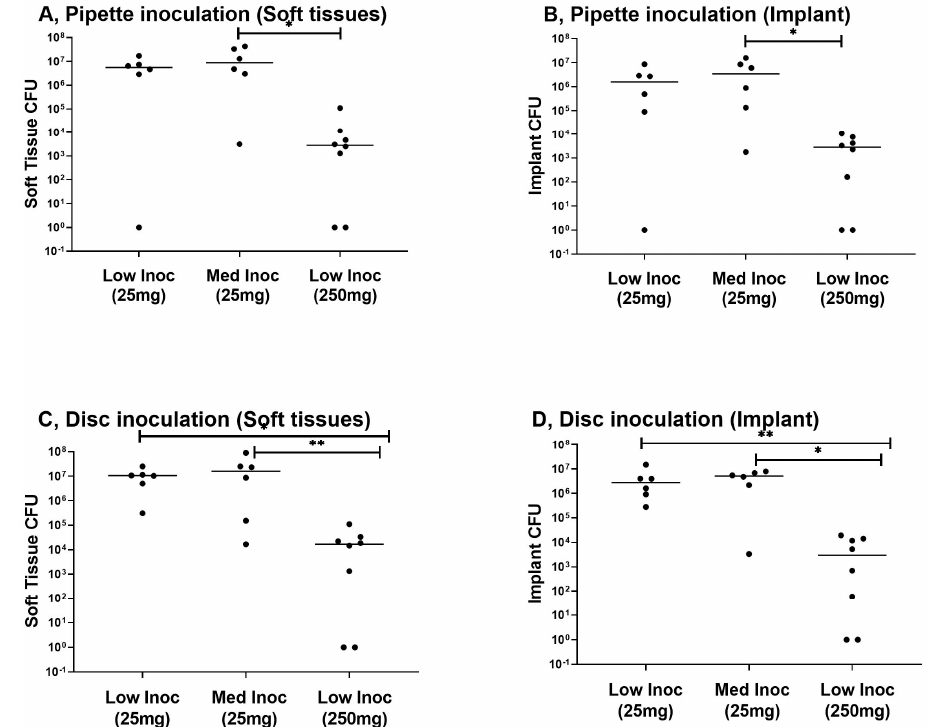
Figure 3. Results of systemic antibiotic prophylaxis phase. Results are grouped according to inoculation method and sample type for the low inoculum, treated with 25 mg (n = 6) or 250 mg (n = 8) of cefazolin and the medium inoculum, treated with 25 mg of cefazolin (n = 6). ( A ) Pipette inoculation, soft tissue sample, * statistical significance between the low inoculum treated with 250 mg of cefazolin and the medium inoculum treated with 25 mg of cefazolin ( p = 0.01); ( B ) Pipette inoculation, implant sample, * statistical significance between the low inoculum treated with 250 mg of cefazolin and the medium inoculum treated with 25 mg of cefazolin ( p = 0.03); ( C ) Disc inoculation, soft tissue sample, * statistical significance between the low inoculum treated with 250 mg of cefazolin and the low inoculum treated with 25 mg of cefazolin ( p = 0.01), ** statistical significance between the low inoculum treated with 250 mg of cefazolin and the medium inoculum treated with 25 mg of cefazolin ( p = 0.02); ( D ) Disc inoculation, implant sample, * statistical significance between the low inoculum treated with 250 mg of cefazolin and the medium inoculum treated with 25 mg of cefazolin ( p = 0.01), ** statistical significance between the low inoculum treated with 250 mg of cefazolin and the low inoculum treated with 25 mg of cefazolin ( p = 0.02). The CFU count is reflected on the y -axis; the x -axis displays inoculum and antibiotic concentration being